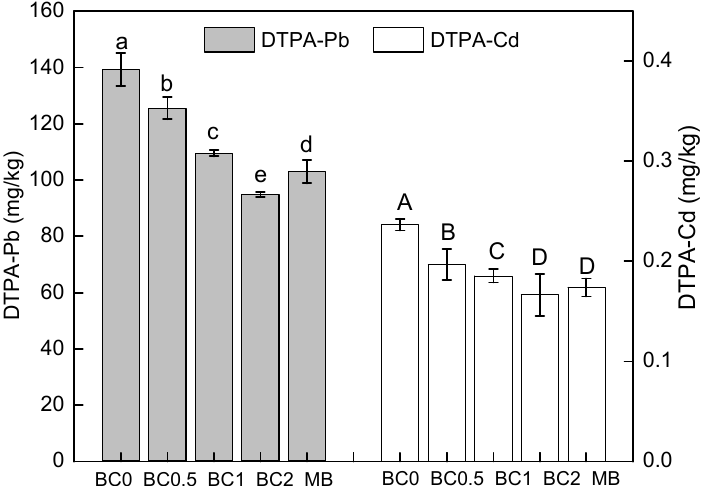
Figure 3. Soil bioavailable DTPA-Pb and DTPA-Cd. BC0, BC0.5, BC1, and BC2 mean as soil applied with T-BC of four rate (0, 0.5, 1, and 2% (w/w)); MB means as soil applied with biochar (2% (w/w)) from mango leaves.